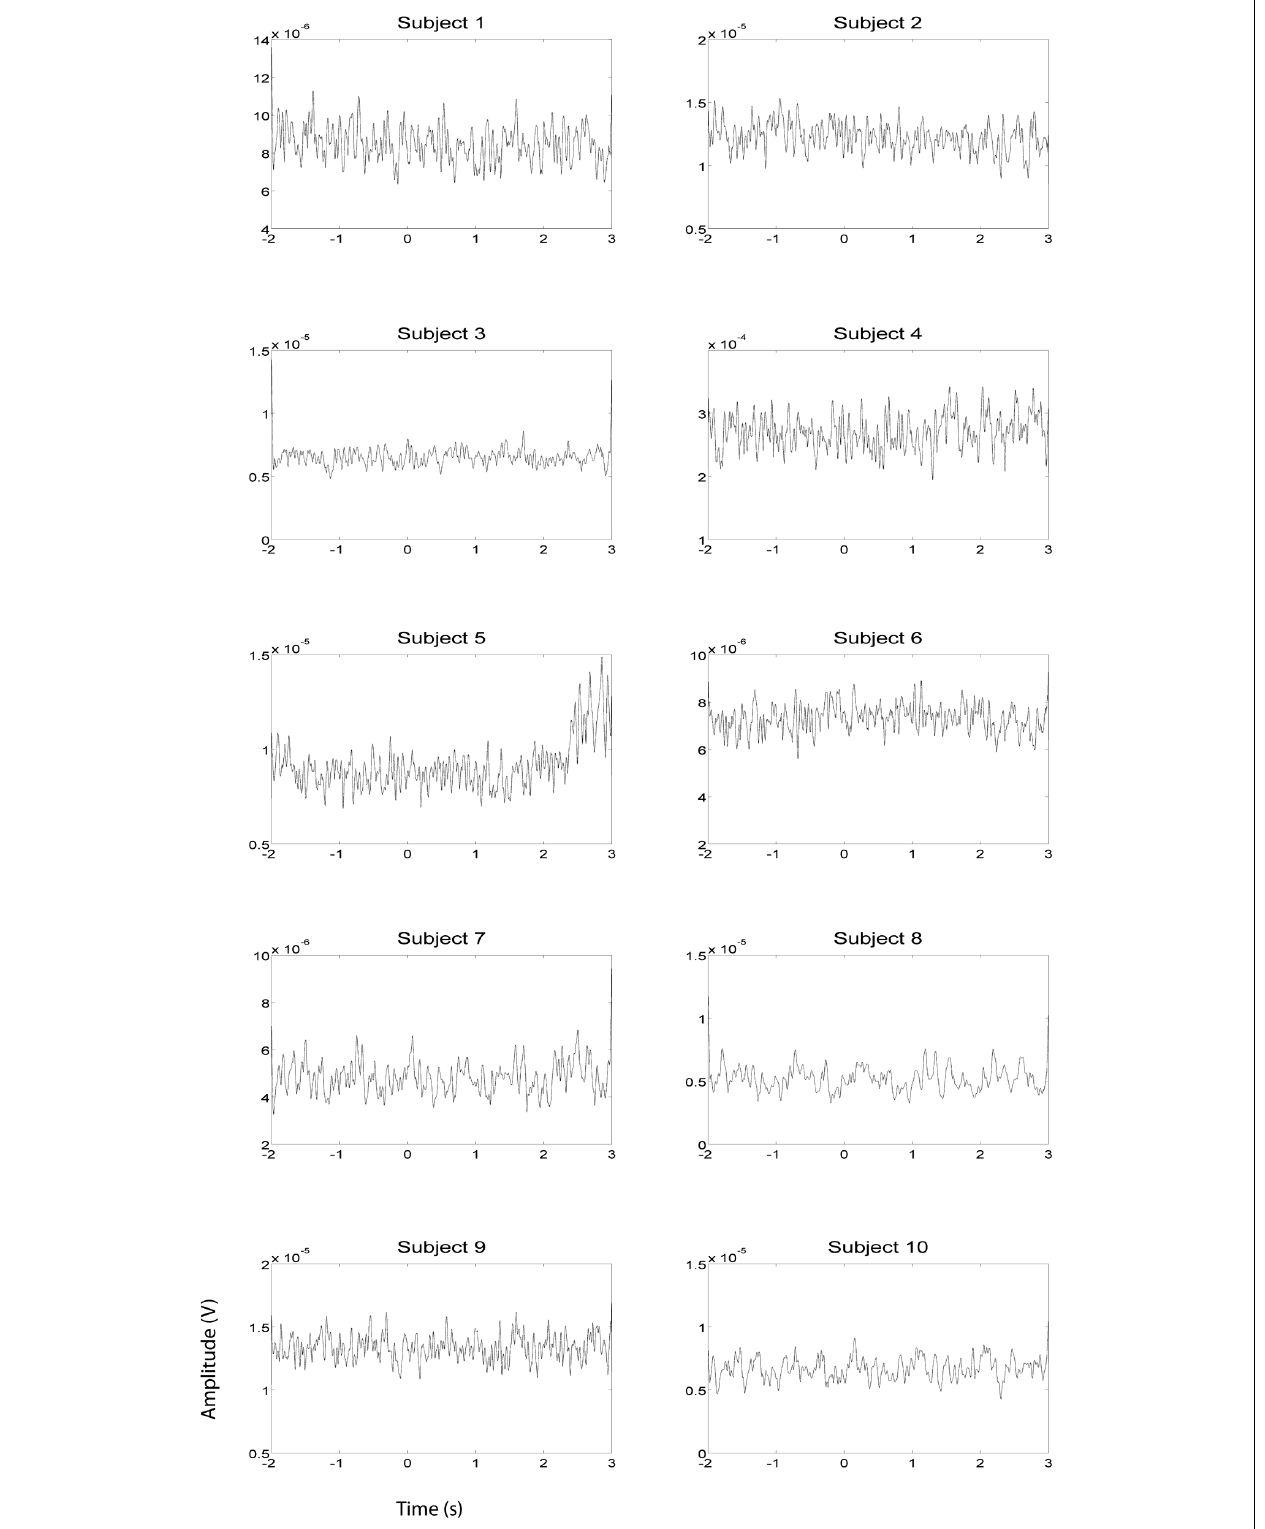
FIGURE 5 | EOG HG magnitude during right hand EEG motor imagery recording sessions ( n = 10). EOG activity was averaged over all trials that were not contaminated by artifacts. Units of the EMG are